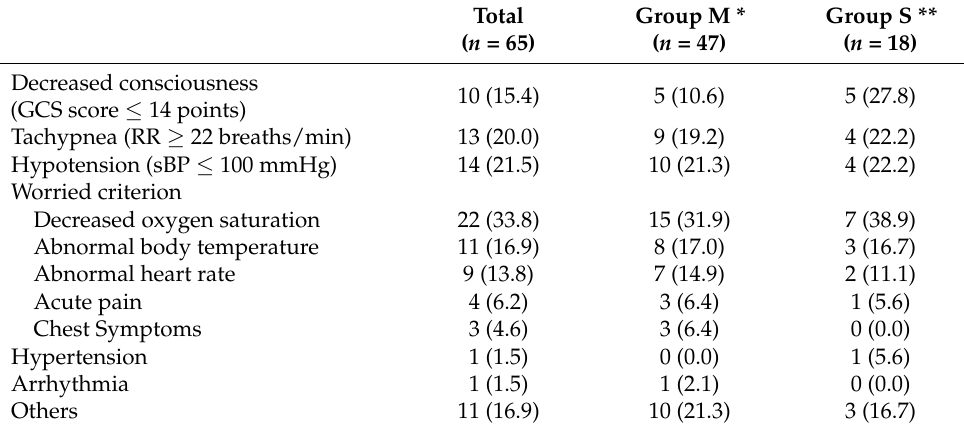
Table 4. Reasons for rapid response team (RRT)